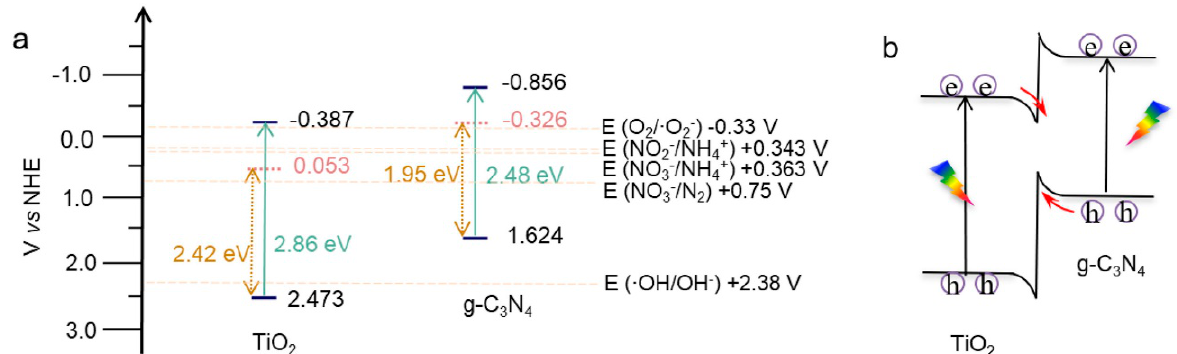
Figure 12. ( a ) Energy band levels of TiO 2 and g − C 3 N 4 ; ( b ) The charge carrier transfer behavior in g-C 3 N 4 /RGO/TiO 2 material [208] (Reprinted with permission from [208] Copyright 2022 Elsevier